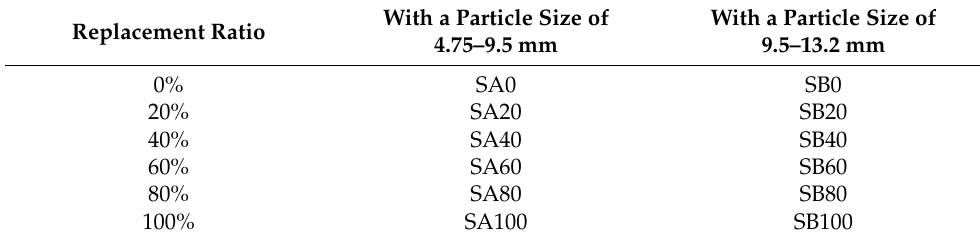
Table 2. Steel slag asphalt